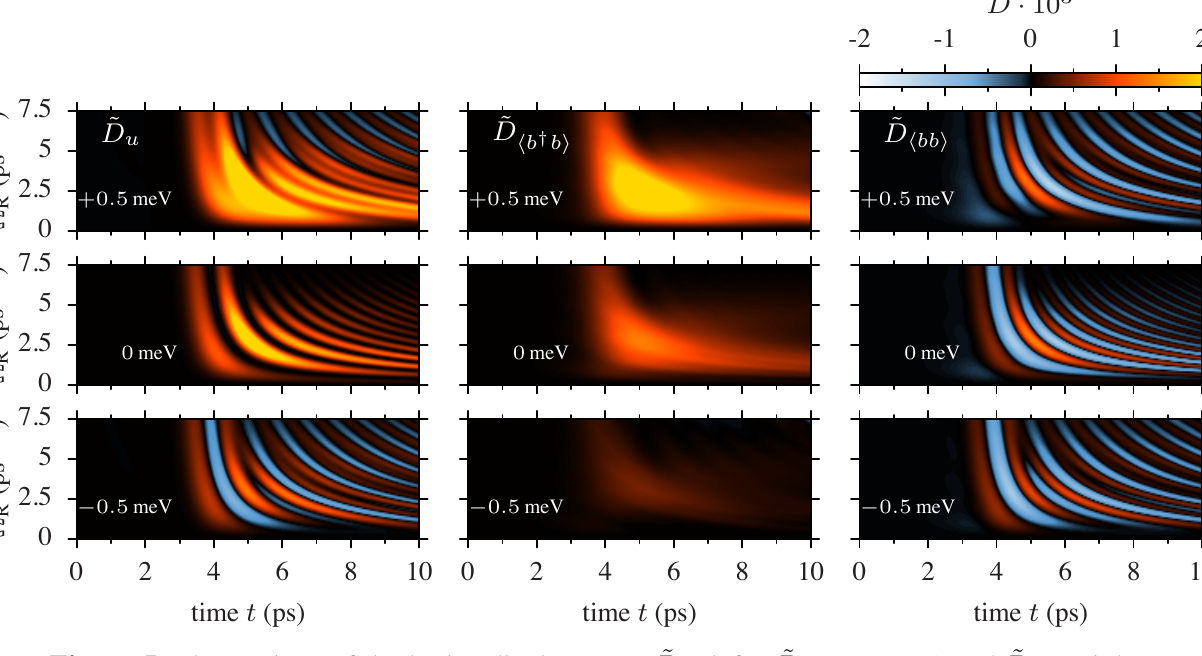
(left), ˜ D (center) and ˜ D u b † b (cid:104) (cid:105) for the detunings δω = +0 . 5 meV R